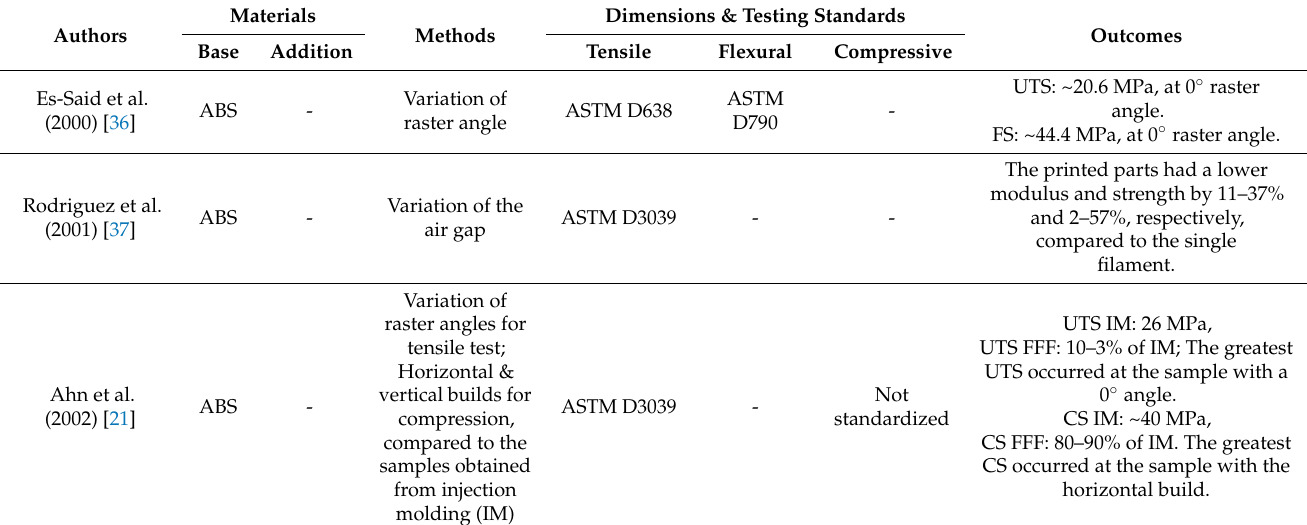
Figure 5. Schematic illustration of various raster angles. Table 1. Research on printing